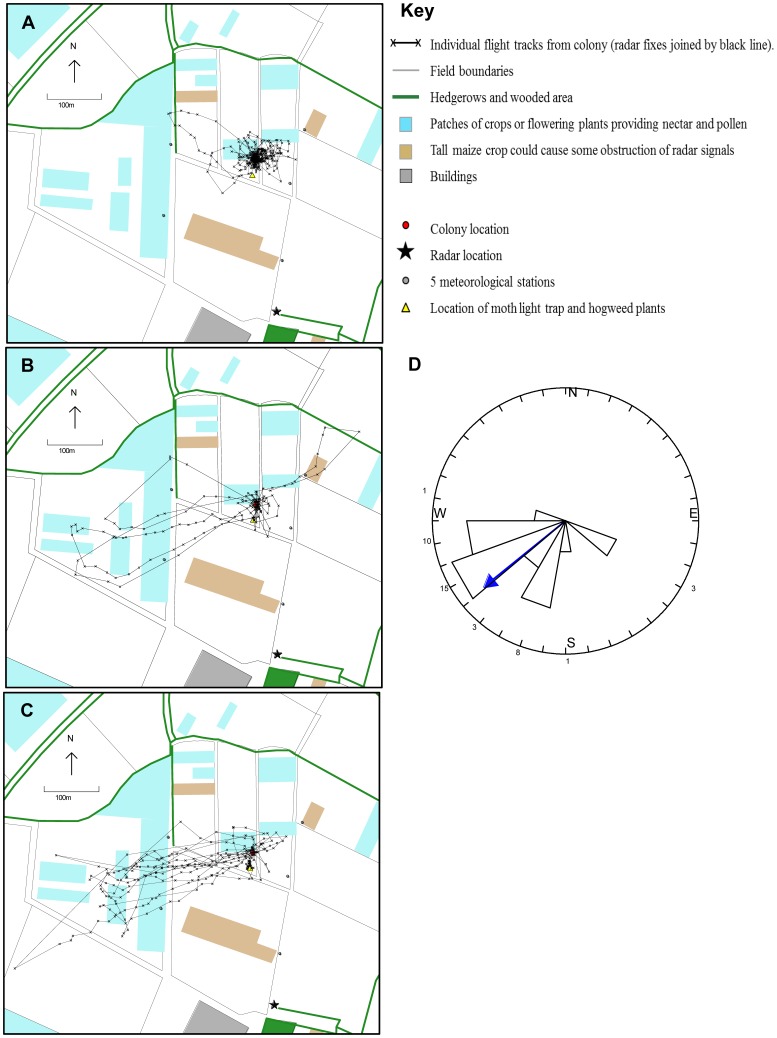
Plots of radar tracked flights (complete) overlaid on the landscape.A) Group 1: bees on first trips (n = 14); B) Group 2: bees on 2nd & 3rd trips (n = 6); C) Group 3: experienced bees that have flown over 6 trips (n = 8). For detail of each flight see videos in Figure S2 and maps in Figure S3. D) Circular histogram of mean wind directions (in degrees) recorded during each tracked flight, demonstrating the wind was usually from the West South West during the study (blue arrow = circular mean). Numbers on outside of circle indicate number in each bin. Means were calculated from wind direction records taken at 10 second intervals at each of five meteorological stations.